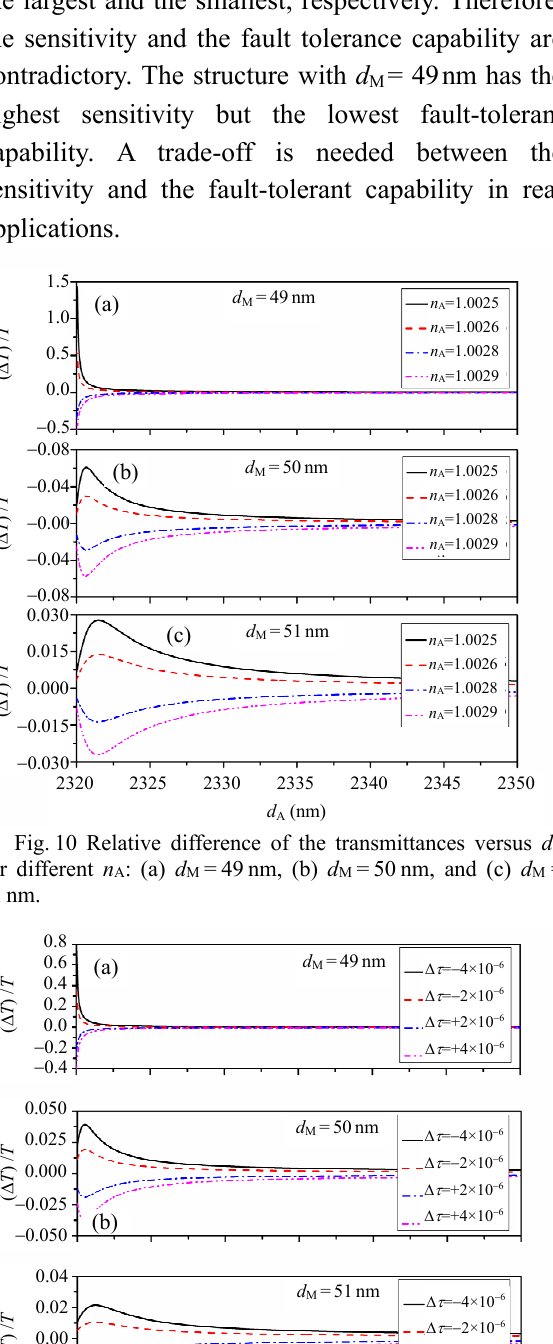
Fig. 11 Relative difference of the transmittances versus d A for different   : (a) d M = 49 nm, (b) d M = 50 nm, and (c) d M = 51